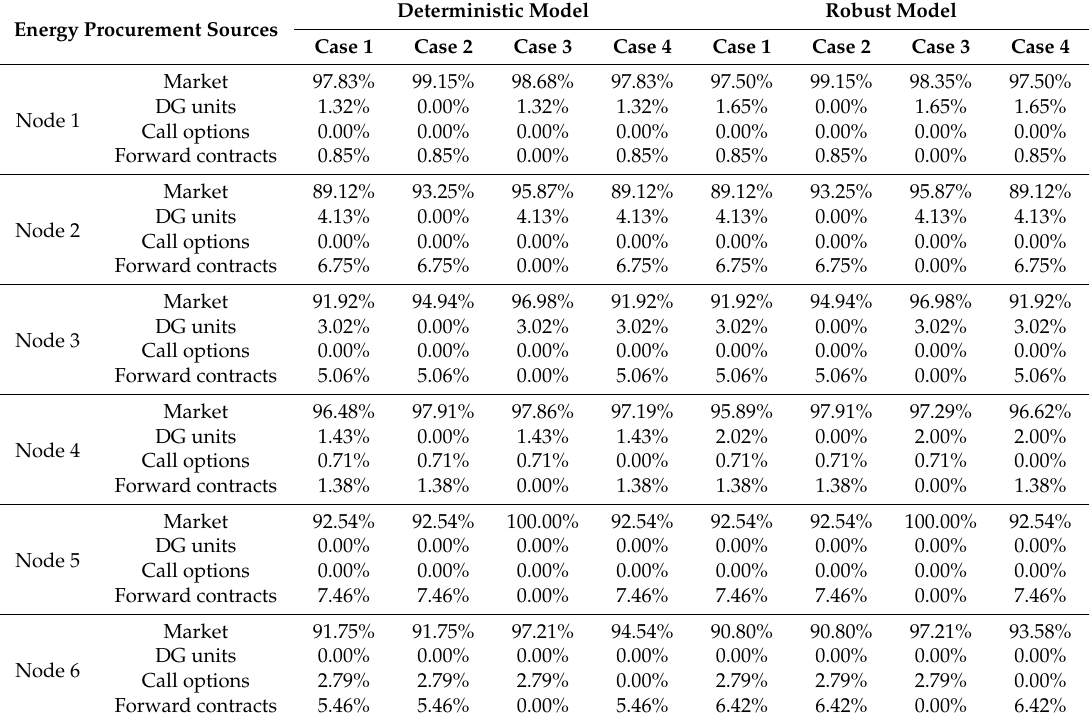
Table 5. Percentage of energy procurement through the market and the risk hedging